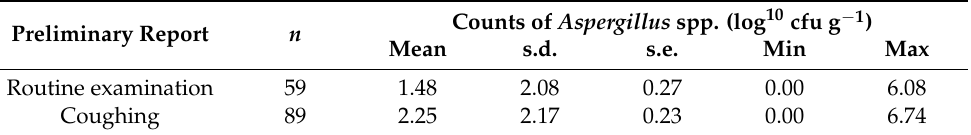
Table 10. Quantitative determination (log 10 cfu g − 1 ) of Aspergillus spp. in forage samples without and with the occurrence of coughing after feeding ( p =